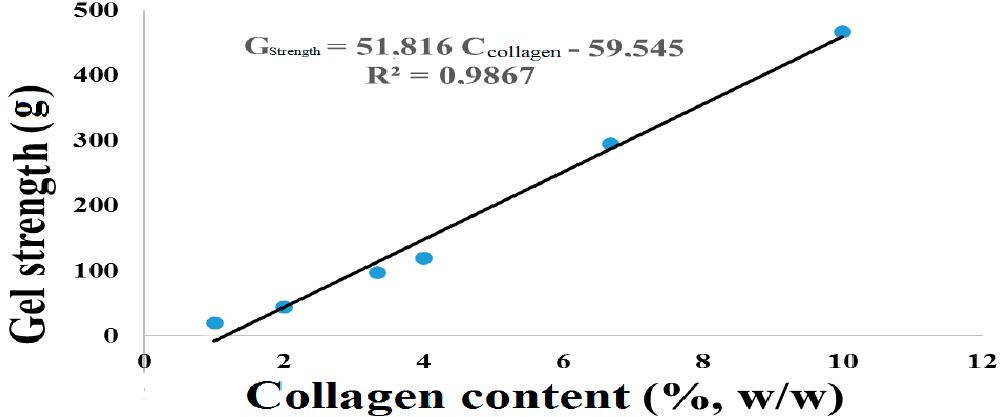
Figure 4. Variation of gel strength with the collagen content in gelatin.